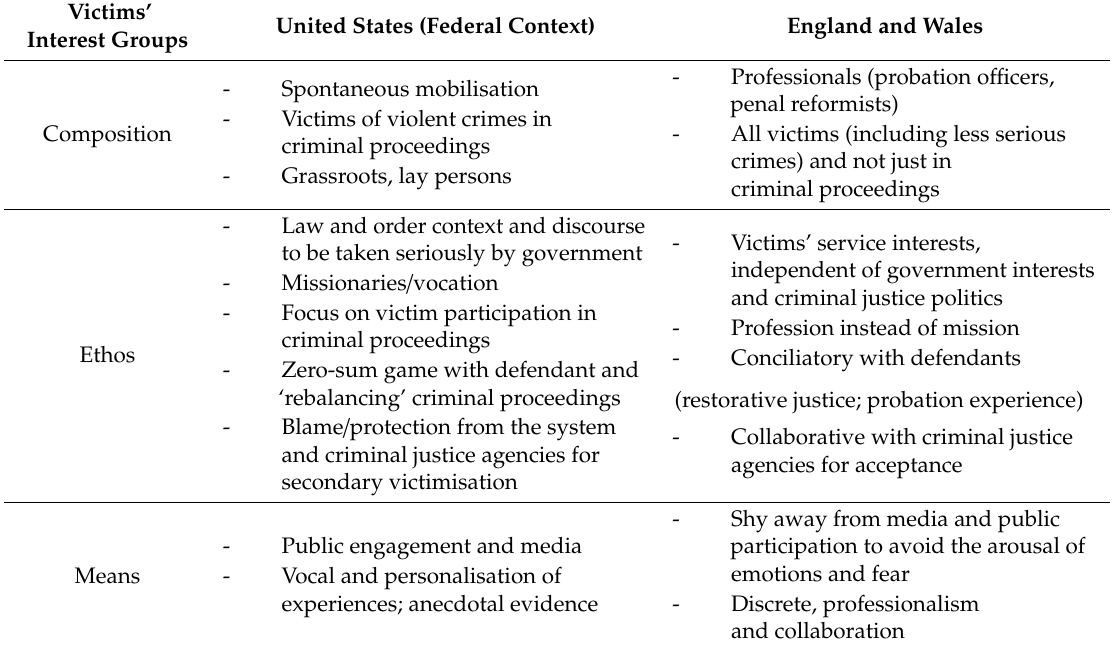
Table 1. Contrasting victims’ interest groups in both